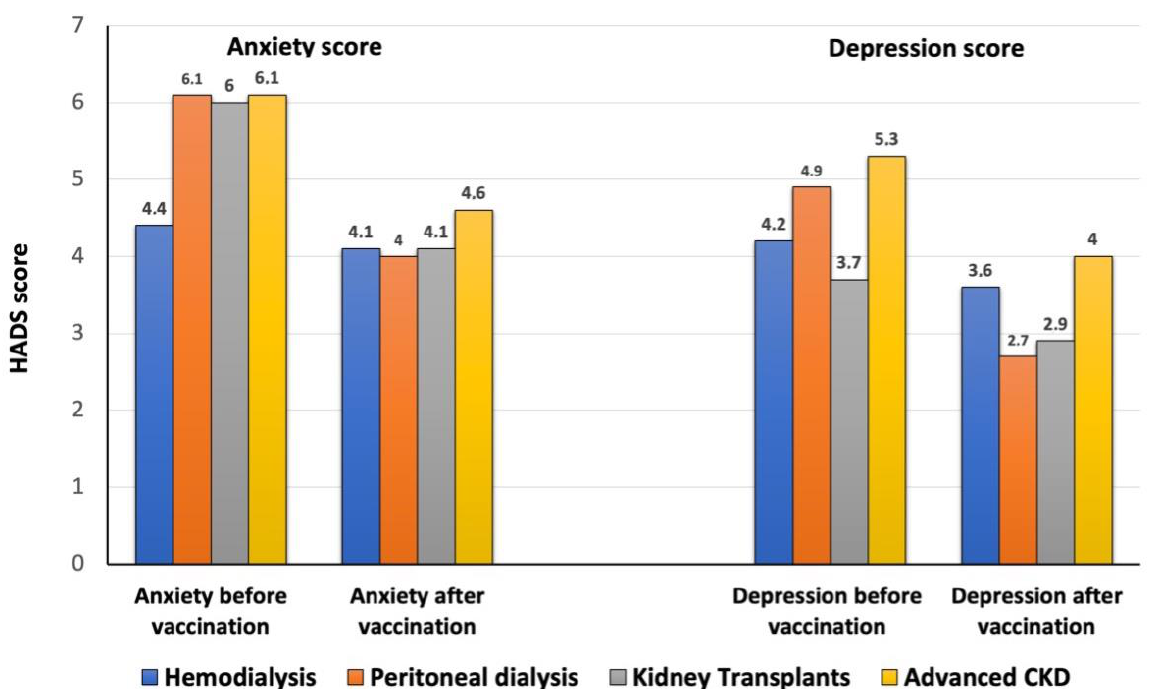
Figure 3. Mean anxiety and depression score by CKD groups. No significant differences were found between the groups. ANOVA test, p = 0.10.